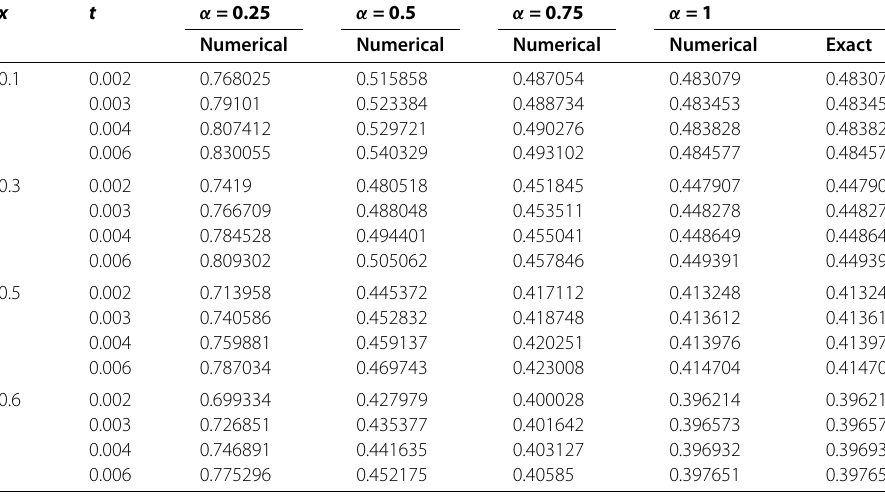
Table 4 The results obtained by the FRDTM for different values of α for Example